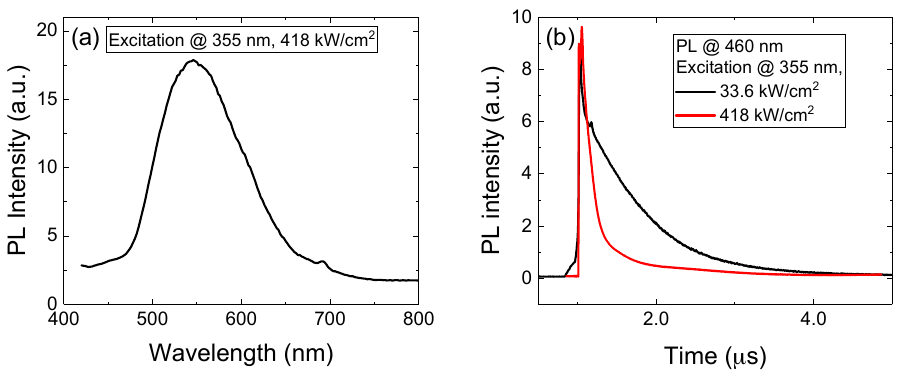
Figure 2. ( a ) Photoluminescence spectrum and ( b ) time-resolved photoluminescence decay at 460 nm of the epitaxial material of the receiver.